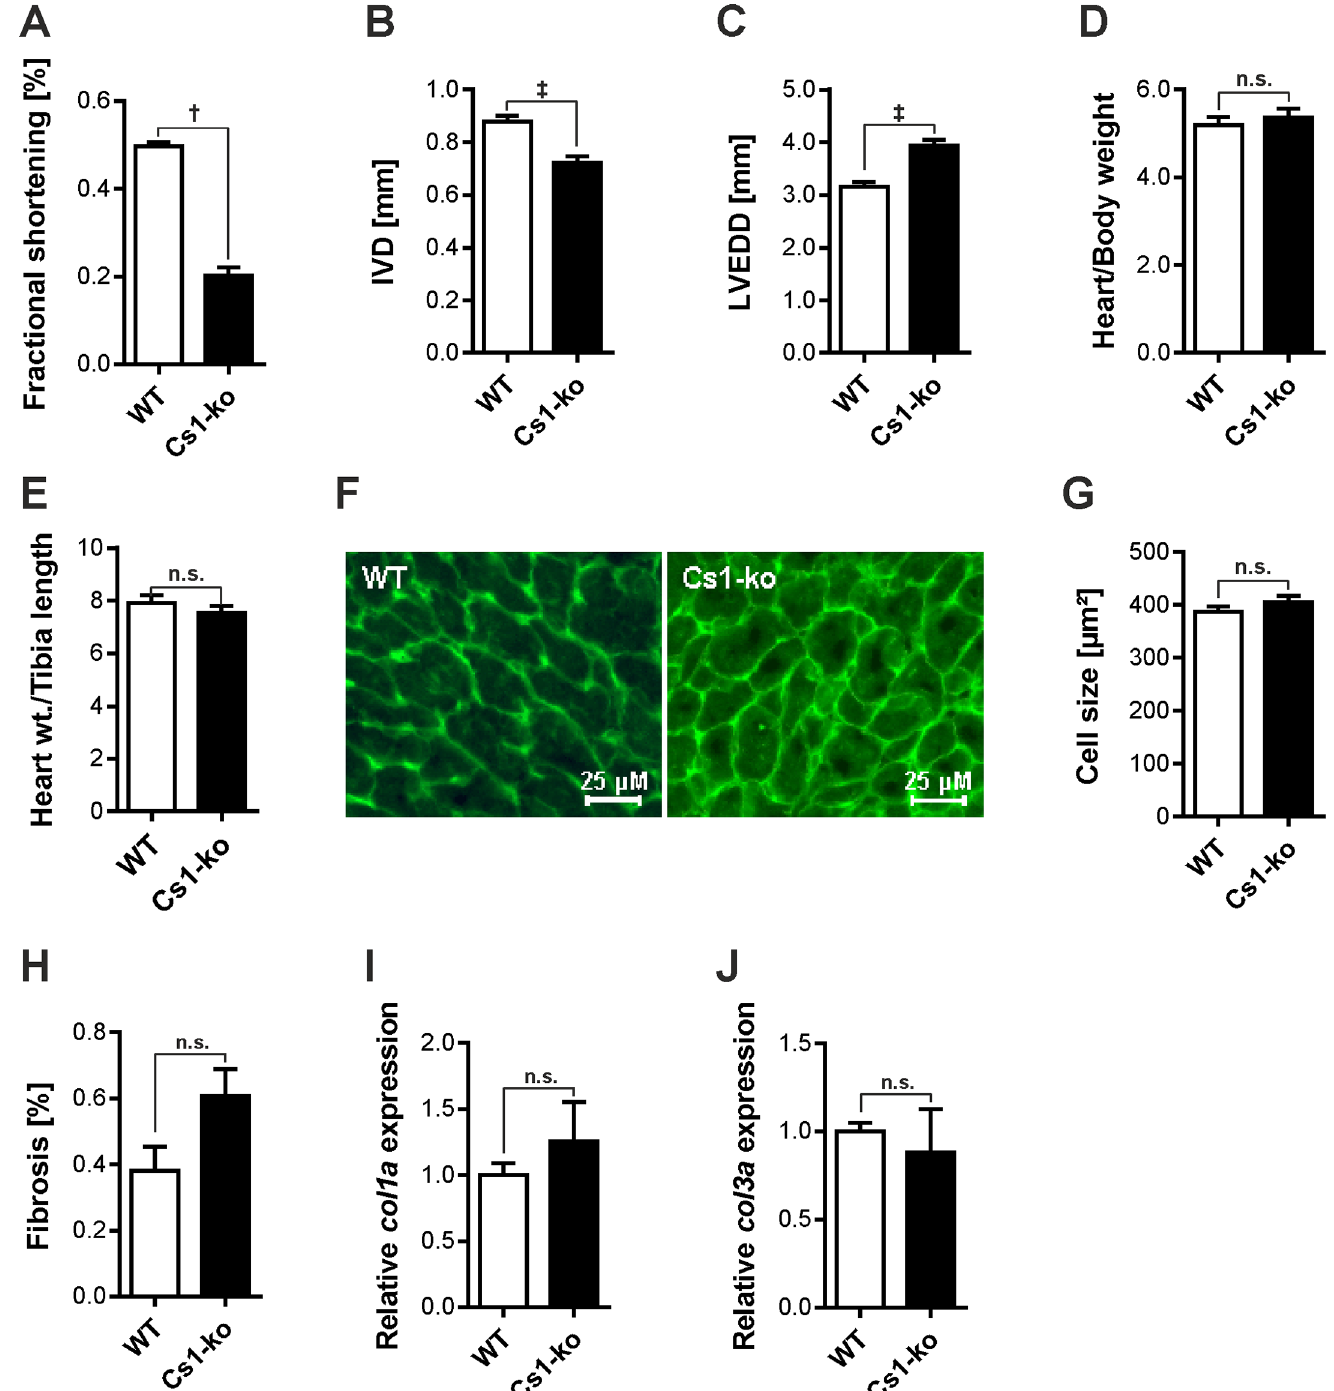
Fig 1. Phenotypic characterization of Calsarcin-1 deficient mice in C57BL/6 background. 13 weeks old mice underwent echocardiographyto assess cardiac function. Reducedfractional shortening( A ), intraventricular diameter(IVD, B ), and increasedleft ventricular end diastolicdiameter (LVEDD, C ) indicates contractiledysfunction and cardiacdilatationof Calsarcin-1 deficientmice (Cs1-ko) comparedto wild-type(WT) littermates. Ratios of heart weight to body weight ( D ), and heart weight to tibia length ( E ) were unchanged betweenboth genotypes suggestingno cardiachypertrophy (N = 7 (WT), and 10 (Cs1-ko) for A-E). In line with unchanged heart weights, there was no difference in cardiomyocyte cell size in Cs1-ko or WT mice as determined by lectin staining ( F ), and measurement of cell surface area ( G ) (N > 150 for G). ( H ) Bar graph indicatingno difference in the fibrotic lesions in Cs1-ko mice comparedto wild-typelittermates (N = 3 each). Similarly, there was no difference in the expressionlevels of collagenI ( I ) and III ( J ),